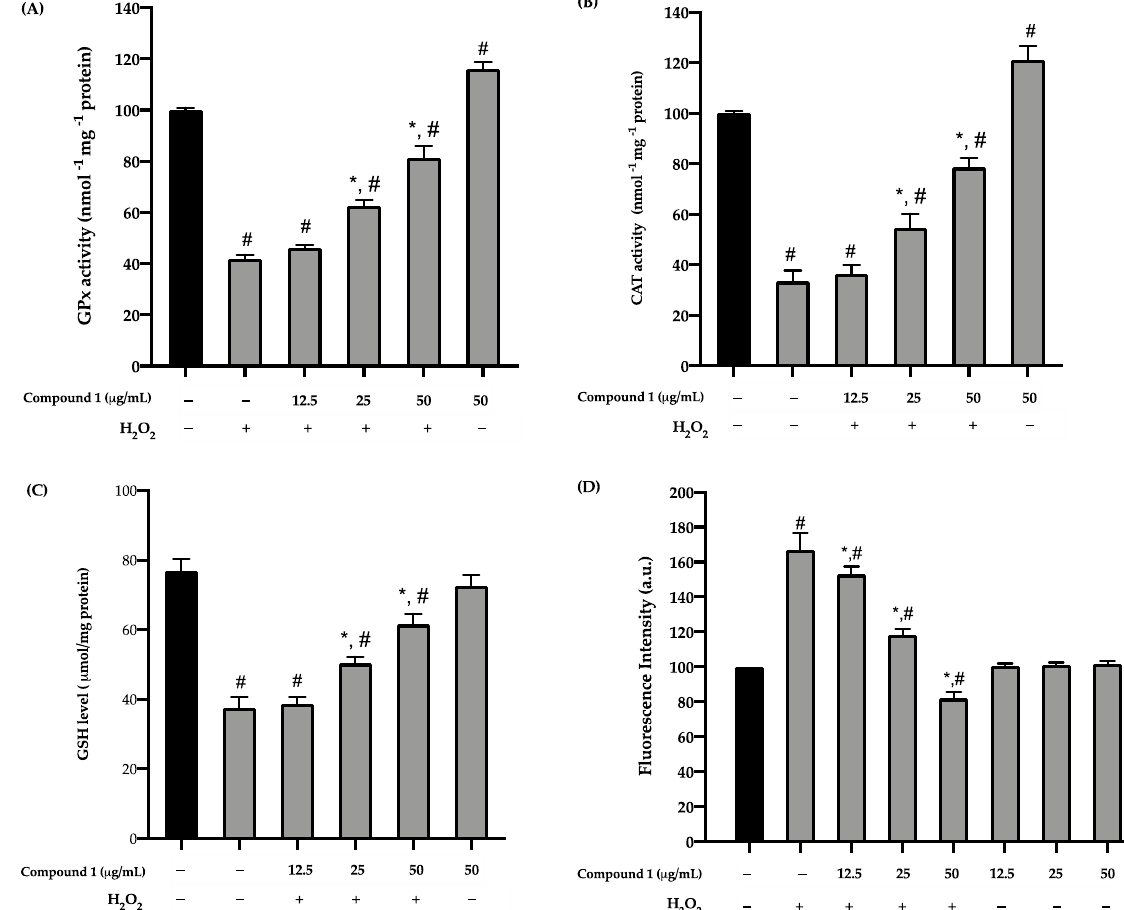
Figure 4. Effect of compound 1 on activities of antioxidant enzymes ( A ) GPx, ( B ) CAT, ( C ), GSH level, and ( D ) Intracellular ROS (fluorescence intensity) in HaCaT keratinocytes induced oxidative stress with H 2 O 2 . Cells were pre-treated with various concentrations of compound 1 (12.5, 25, and 50 µ g/mL) for 24 h exposure to 500 µ mol/L of H 2 O 2 for 1 h. Graphs represent the mean ± SD values of four replications. * p < 0.05 indicates significant differences from the H 2 O 2 stimulation group, # p < 0.05 indicates significant differences from the control